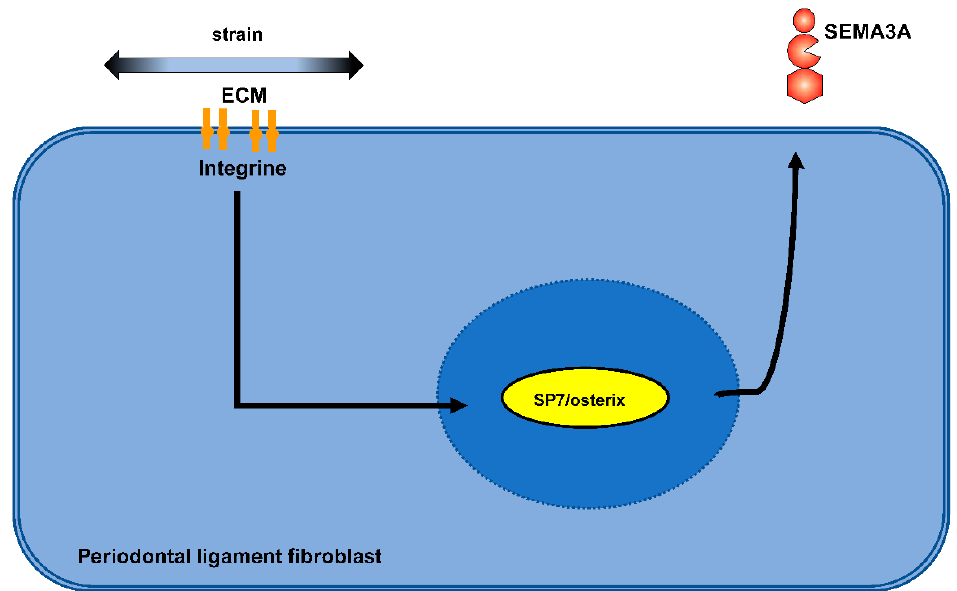
Figure 2. Sema3a was upregulated by stretch forces via Osterix induction in periodontal ligament Figure fibroblasts.